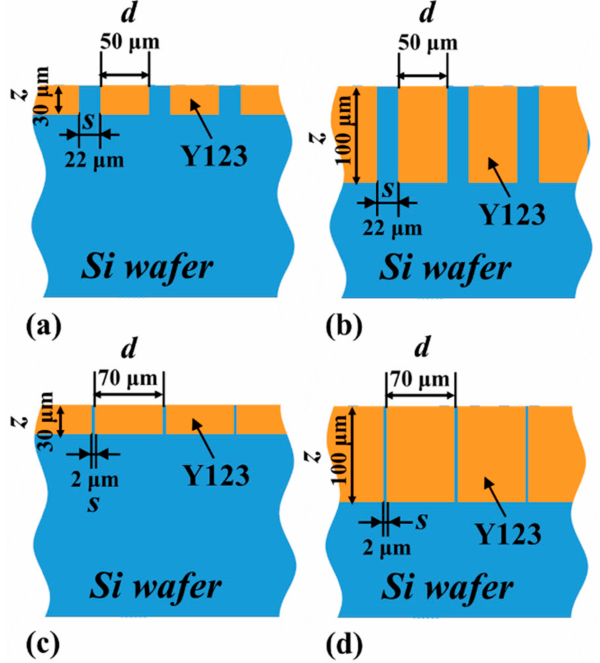
Figure 17. Schematic summary of the combinations of the wafer coil design parameters, d , s , z , examined. ( a ) d = 50 µ m, s = 22 µ m, z = 30 µ m, ( b ) d = 50 µ m, s = 22 µ m, z = 100 µ m, ( c ) d = 70 µ m, s = 2 µ m, z = 30 µ m, ( d ) d = 70 µ m, s = 2 µ m, z = 100 µ